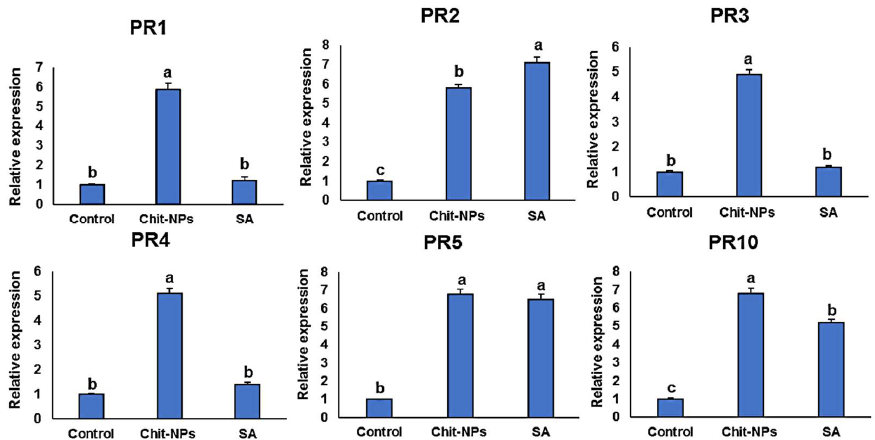
Figure 10. Effect of chitosan nanoparticles (Chit-NPs) and salicylic acid (SA) on the relative transcription levels of PR1-PR5 and PR10 genes in infected wheat plants at 1 day post inoculation. The letters (a, b and c) denote significant difference.